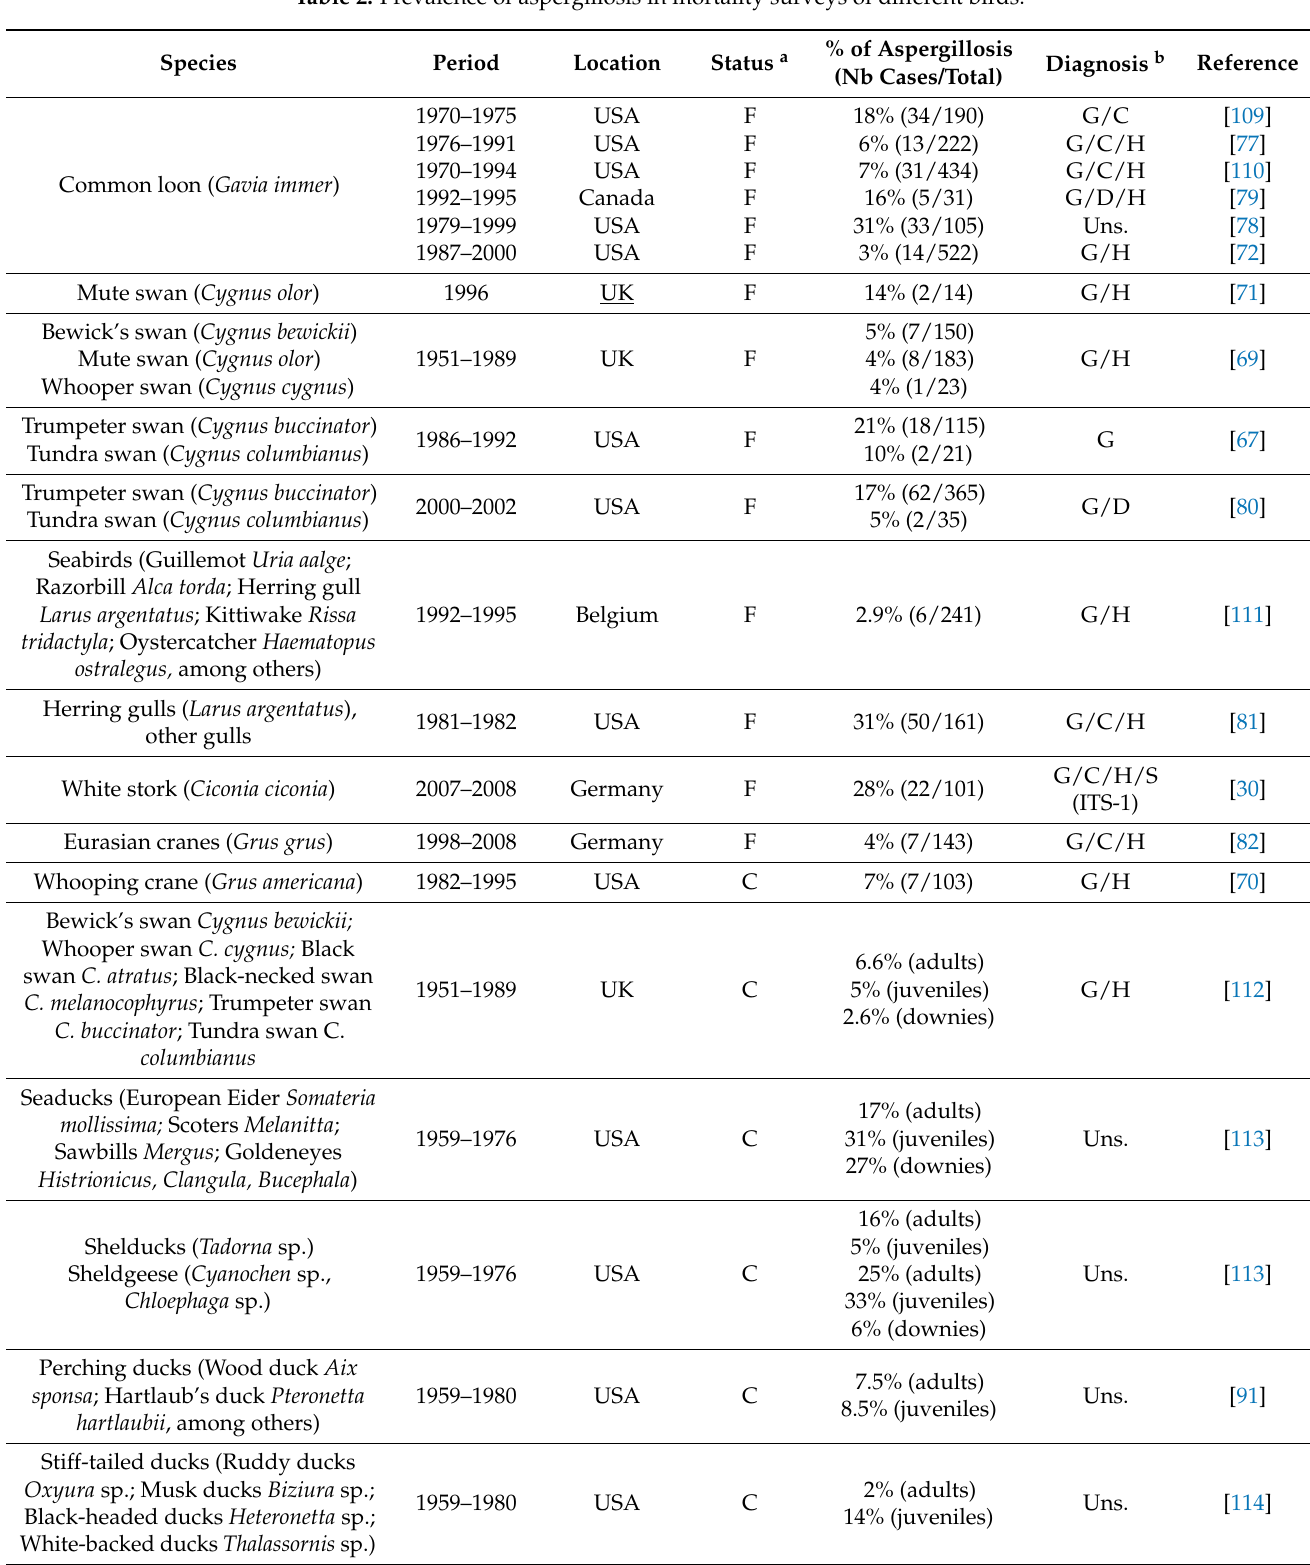
Table 2. Prevalence of aspergillosis in mortality surveys of different